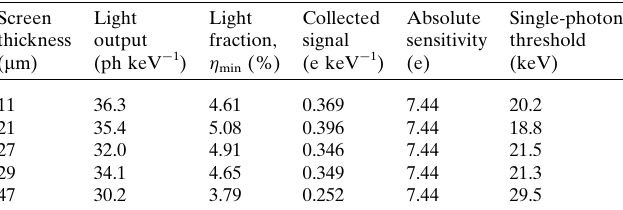
Table 6 Single X-ray photon sensitivity thresholds (with four pixels above the noise) with GOS:Tb scintillating screens and a camera pixel size of 26 m m. Screen thickness